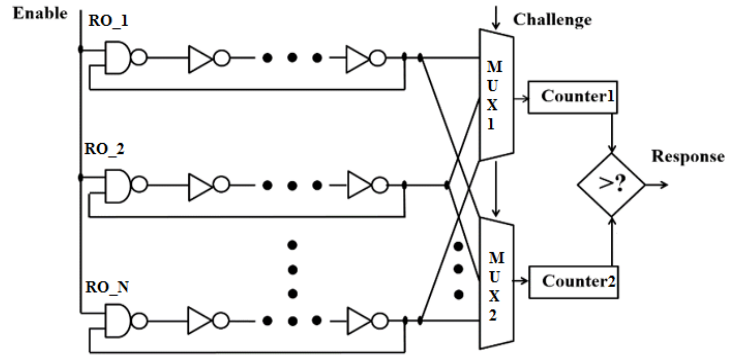
Figure 3. Ring oscillator PUF (ROPUF)